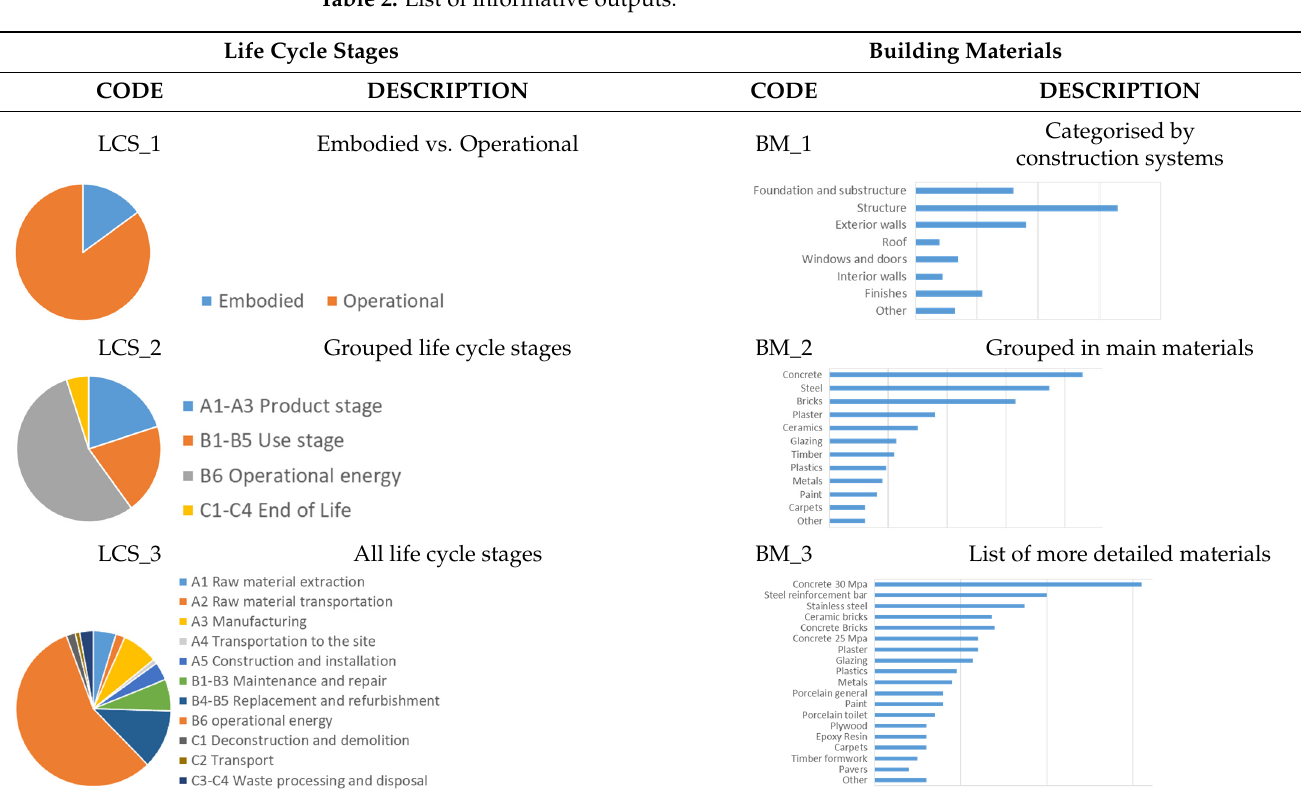
Table 2. List of informative outputs.